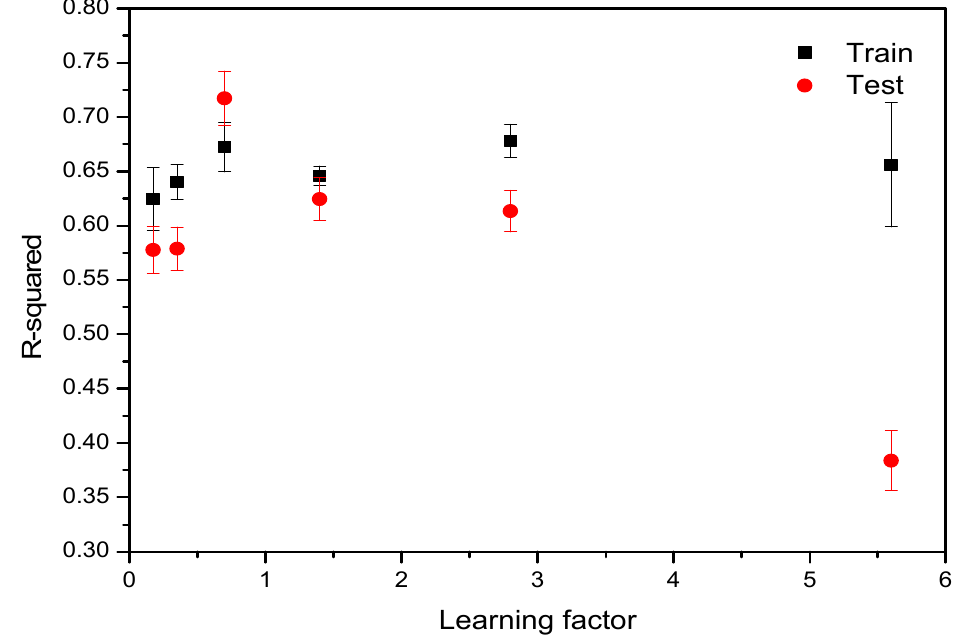
Figure 4. Effect of learning factor on variations in R 2 between the measurements and simulated val- ues.